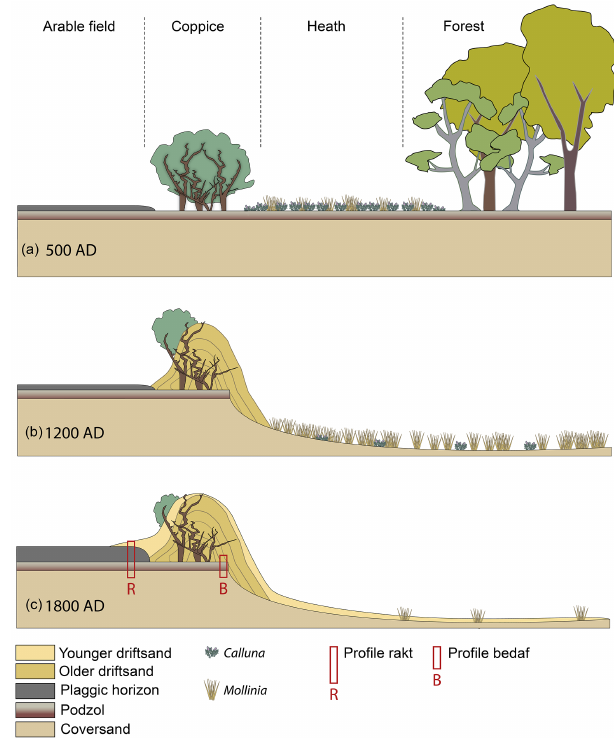
Figure 11. Sequence of development phases of the Bedafse Bergen and its soil archives.